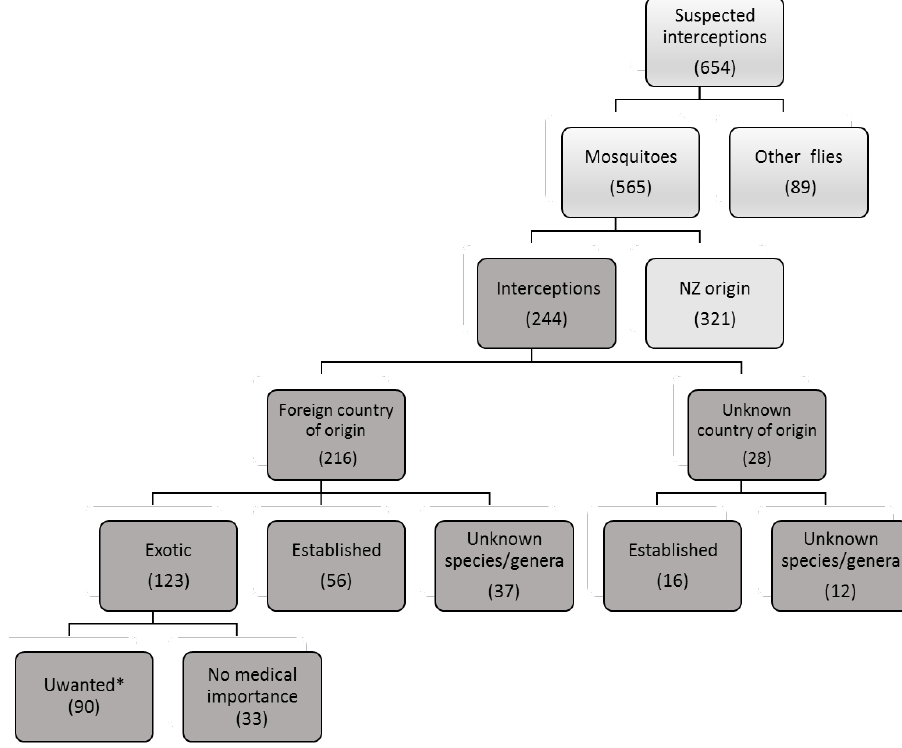
Figure 2. New Zealand Interception records, July 2001 — March 2018.